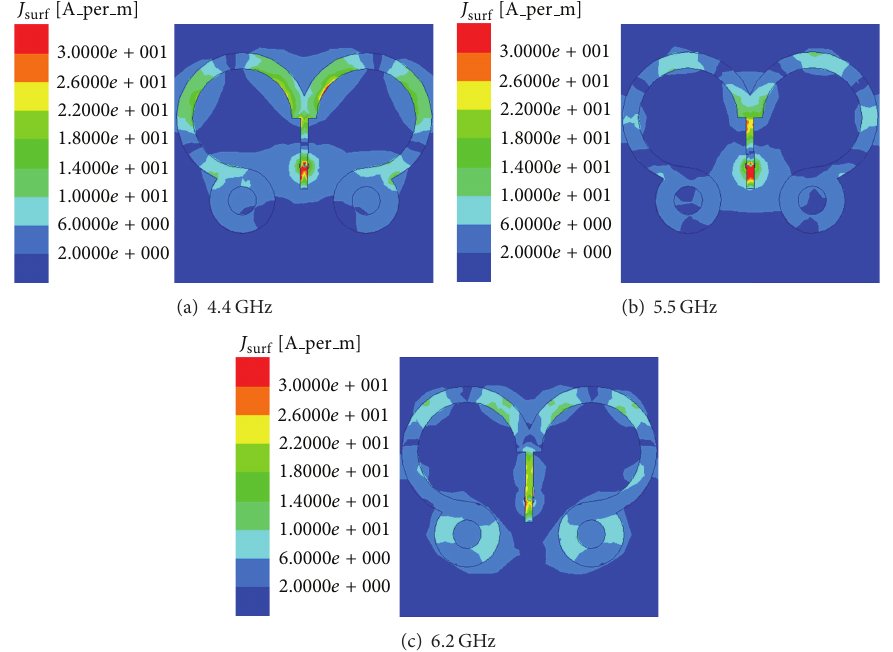
Figure 9: Current distribution of the proposed antenna at different